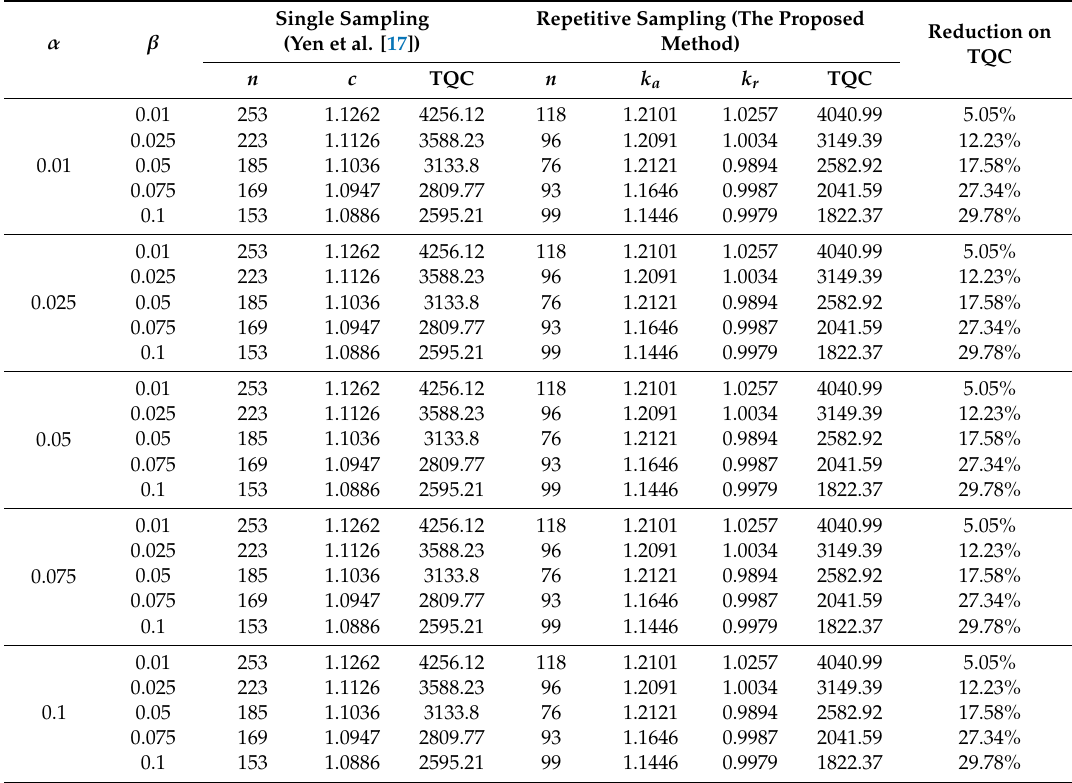
Table 1. Parameters of the rectifying sampling plans and their corresponding total quality cost (TQC). Single Sampling Repetitive Sampling (The Proposed Reduction on α β (Yen et al. [17]) Method)